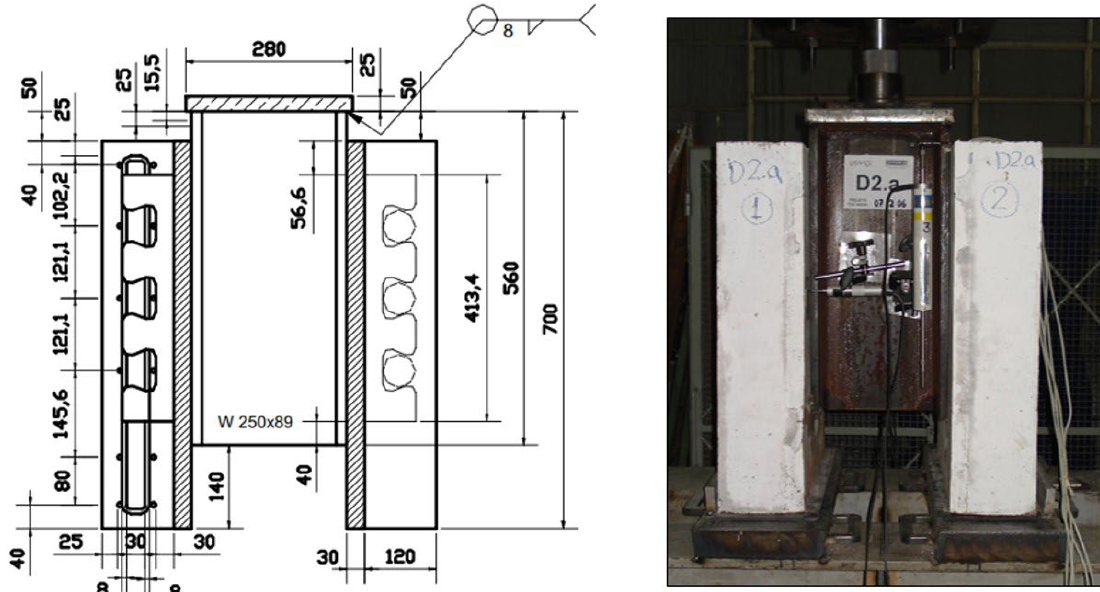
Figure 6. Dimensions of specimens (in mm) and experiment setup (group